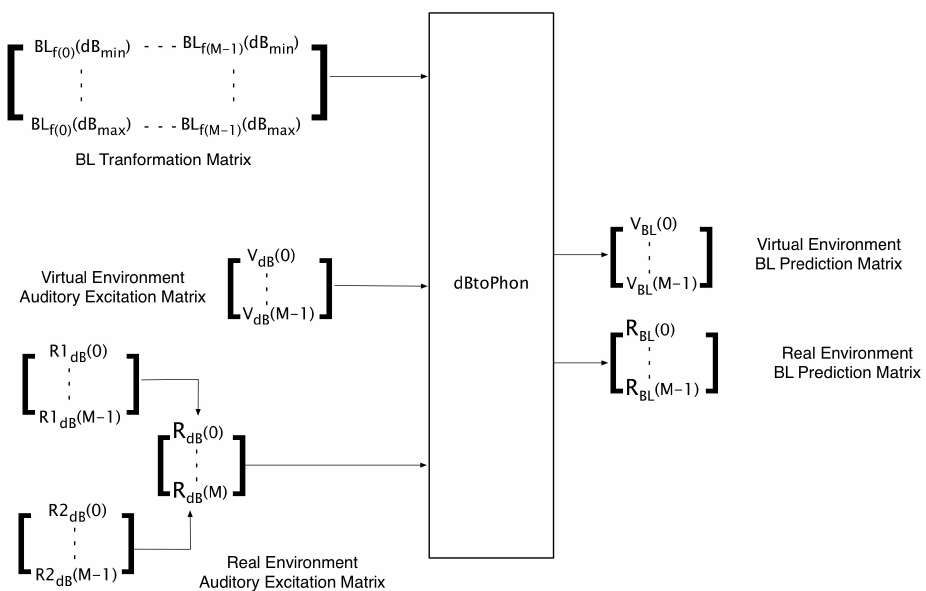
Figure 7. This figure presents the methodology of BL prediction matrix for real and virtual environments.